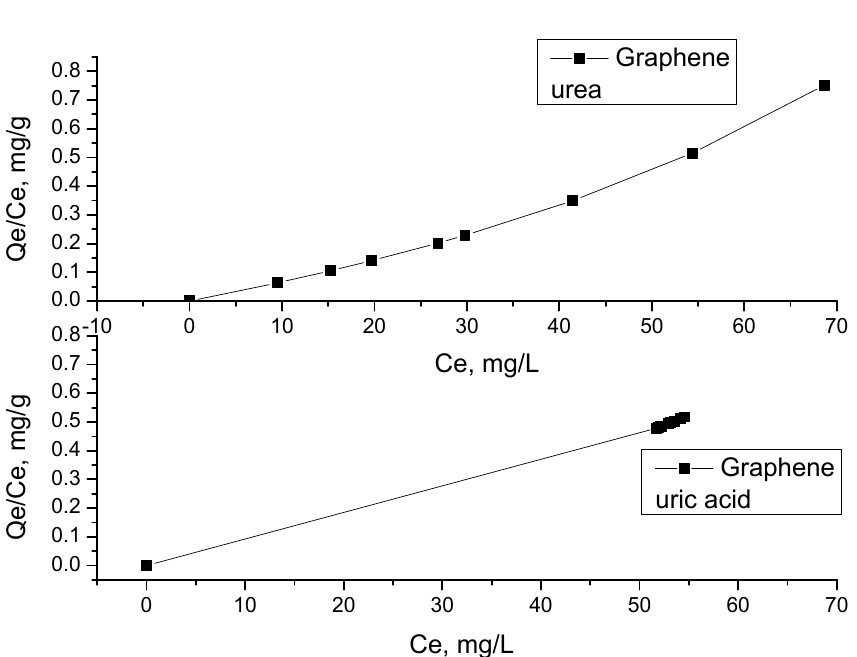
Figure 12. Langmuir model of adsorption for urea and uric acid of graphene.